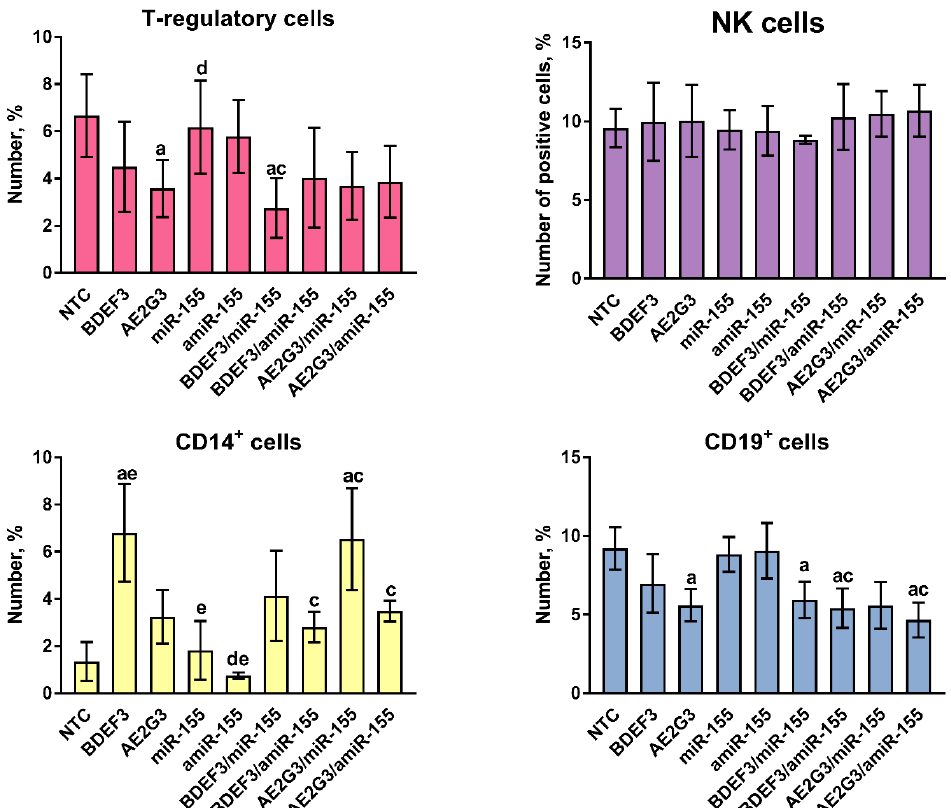
Figure 3. Evaluation of subsets percentage after the treatment by dendriplexes or their components (72 h): T-regulatory cells (CD3 + CD4 + CD25 + CD127 low ), NK-cells (CD16 + CD56 + ), B-lymphocytes (CD45 + CD19 + ). Mann–Whitney test was used. Letters mark significant differences ( p < 0.05): “a”—in comparison with NTC, “c”—in comparison with treatment by free miR, “d”—in comparison with treatment by BDEF33-based complex, “e”—in comparison with by AE2G3-based